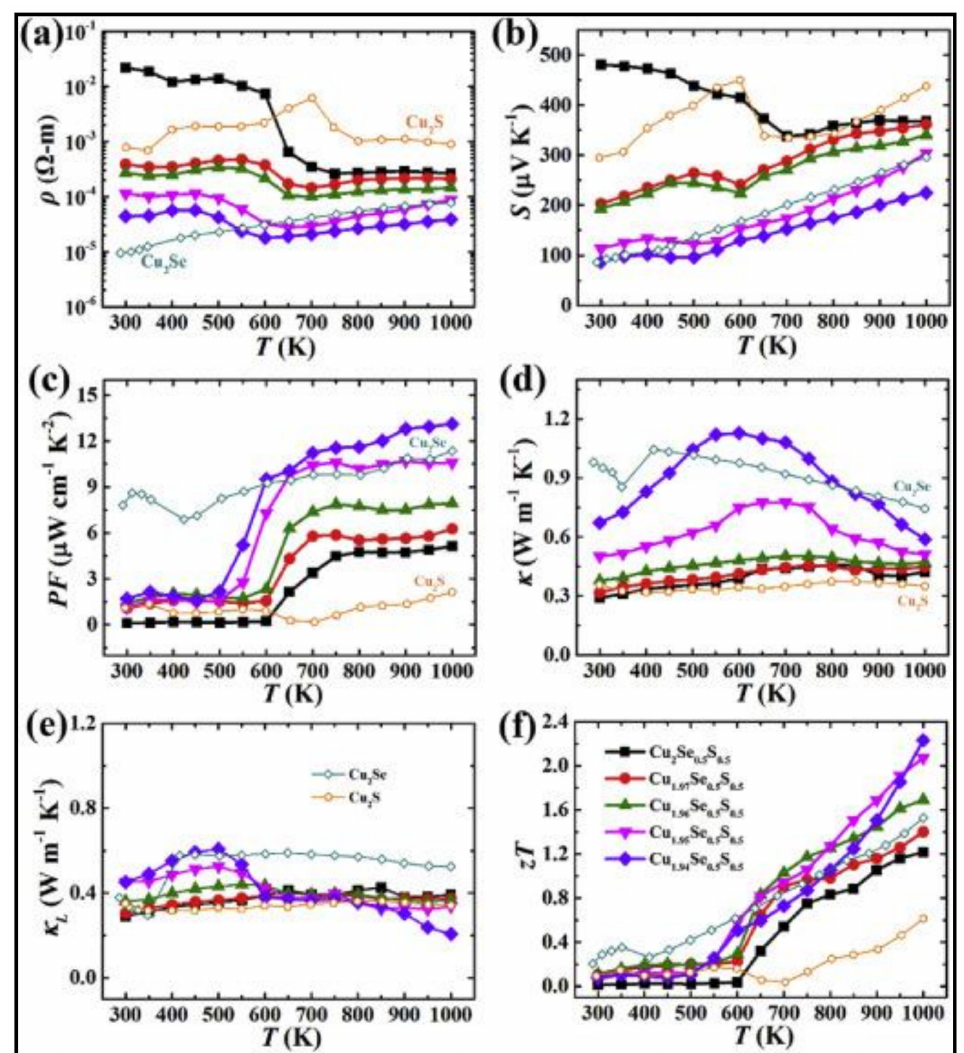
Figure 4. Temperature-dependent thermoelectric properties of Cu 2 − y Se 0.5 S 0.5 . ( a ) Electrical resistivity, ( b ) Seebeck coefficient, ( c ) power factor, ( d ) total thermal conductivity, ( e ) lattice thermal conductivity, ( f ) figure of merit ZT, Reproduced with permission from [33] Copyright © 2017,